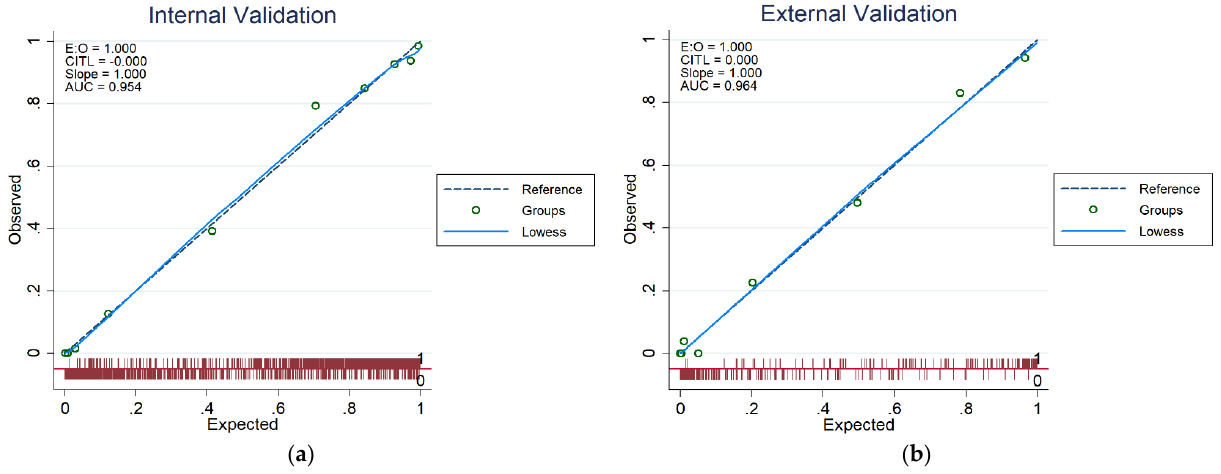
Figure 4. Calibration graphs comparing calculated CKD probability and actual value for ( a ) the train set (internal) validation, ( b ) the test data validation.